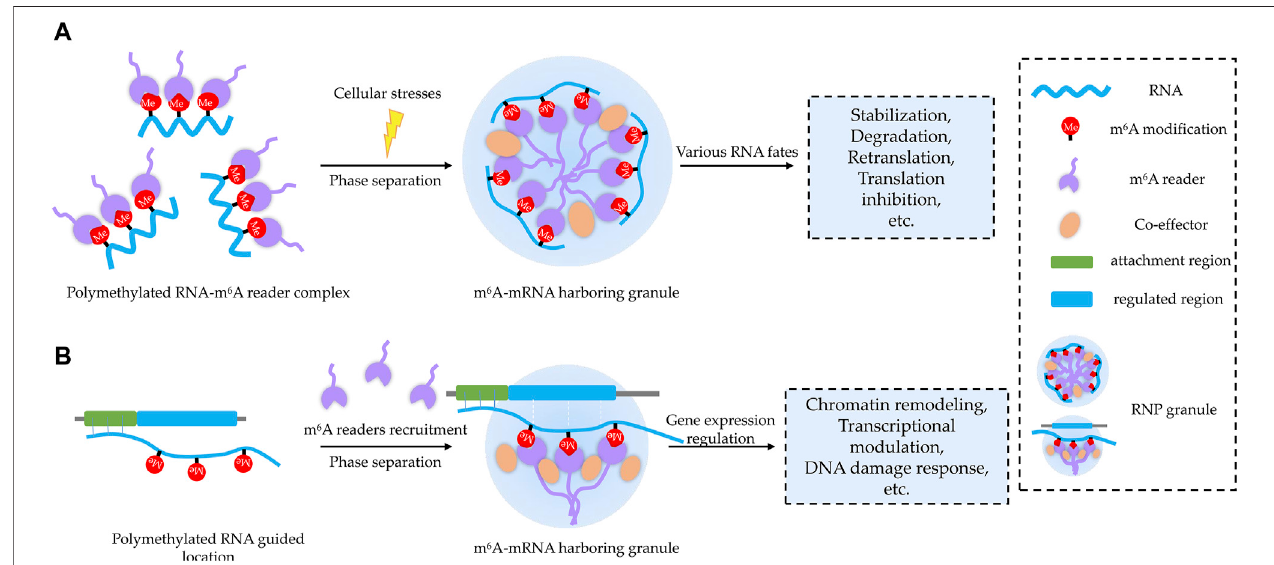
FIGURE 3 | Two proposed working patterns for m 6 A-related BioMCs. (A) m 6 A modi fi cation acts as a sorting marker to decide RNA components and their associated molecular partnersinside thecondensates upon stress,and forming BioMCswill facilitate regulation ofm 6 ARNA for stress response. (B) On nascent RNAs, m 6 Aactsasabeacontorecruitm 6 Areaders,andthenm 6 ARNA – readercomplexesstimulateformationofBioMCs,whichplayimportantrolesforchromatinremodeling, transcriptional regulation, DNA damage response,